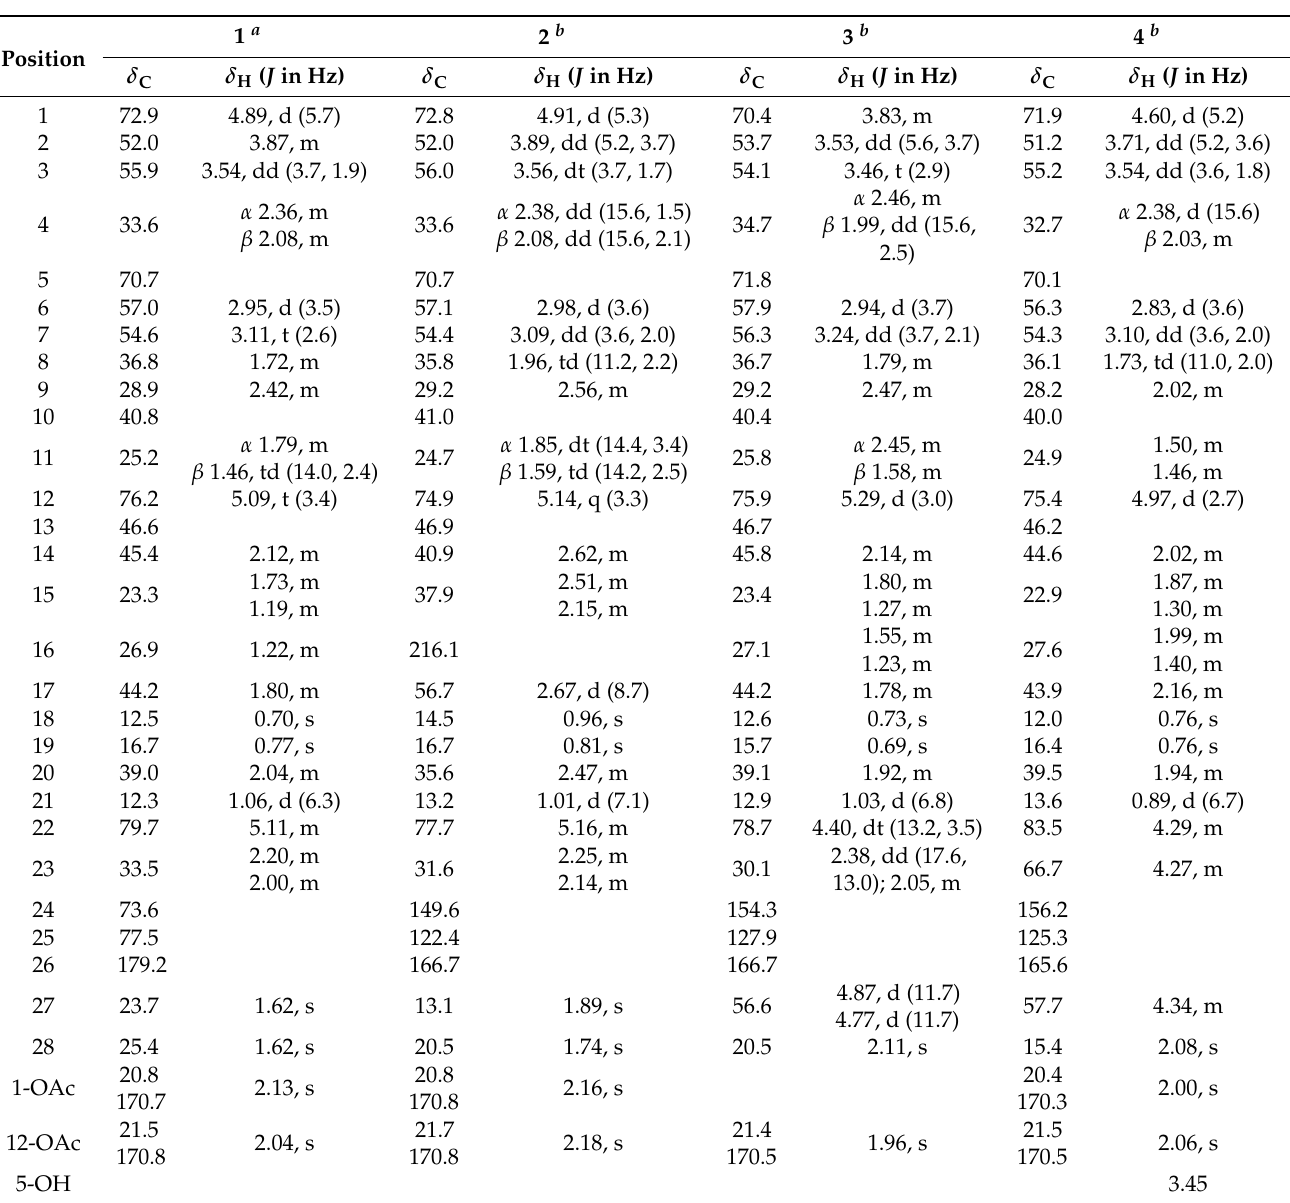
Table 1. 1 H and 13 C NMR data for compounds 1 – 4 ( δ in ppm, J in Hz, in pyridine- d 5